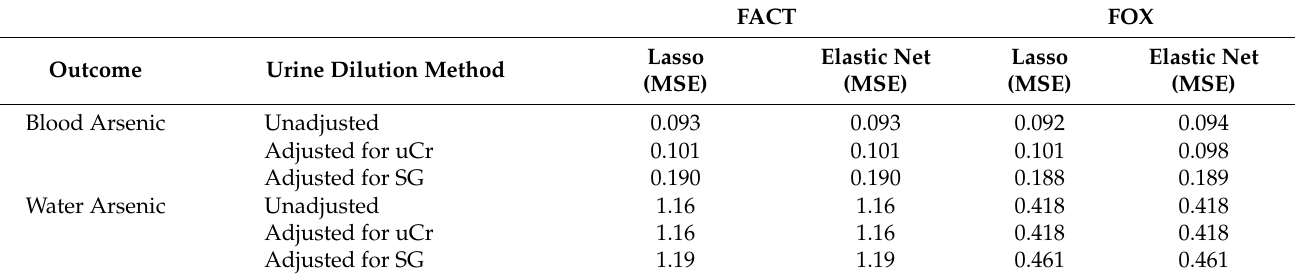
Figure A1. Distribution of urine creatinine and specific gravity in FACT ( A , C ) and FOX ( B , D ), respectively. Table A1. Sensitivity analyses using lasso and elastic net regression to predict blood and water arsenic in FACT and FOX.